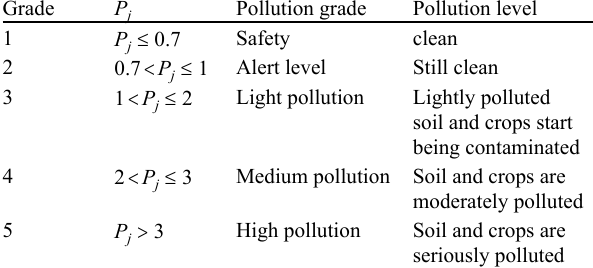
Table 3 Soil pollution grade standards Grade